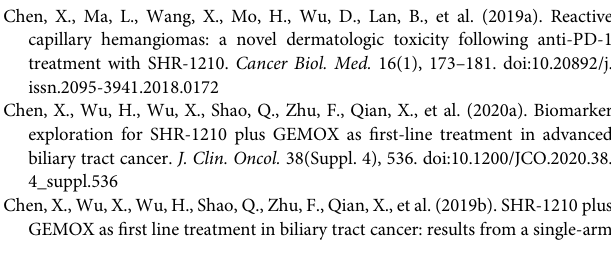
Frontiers in Pharmacology |